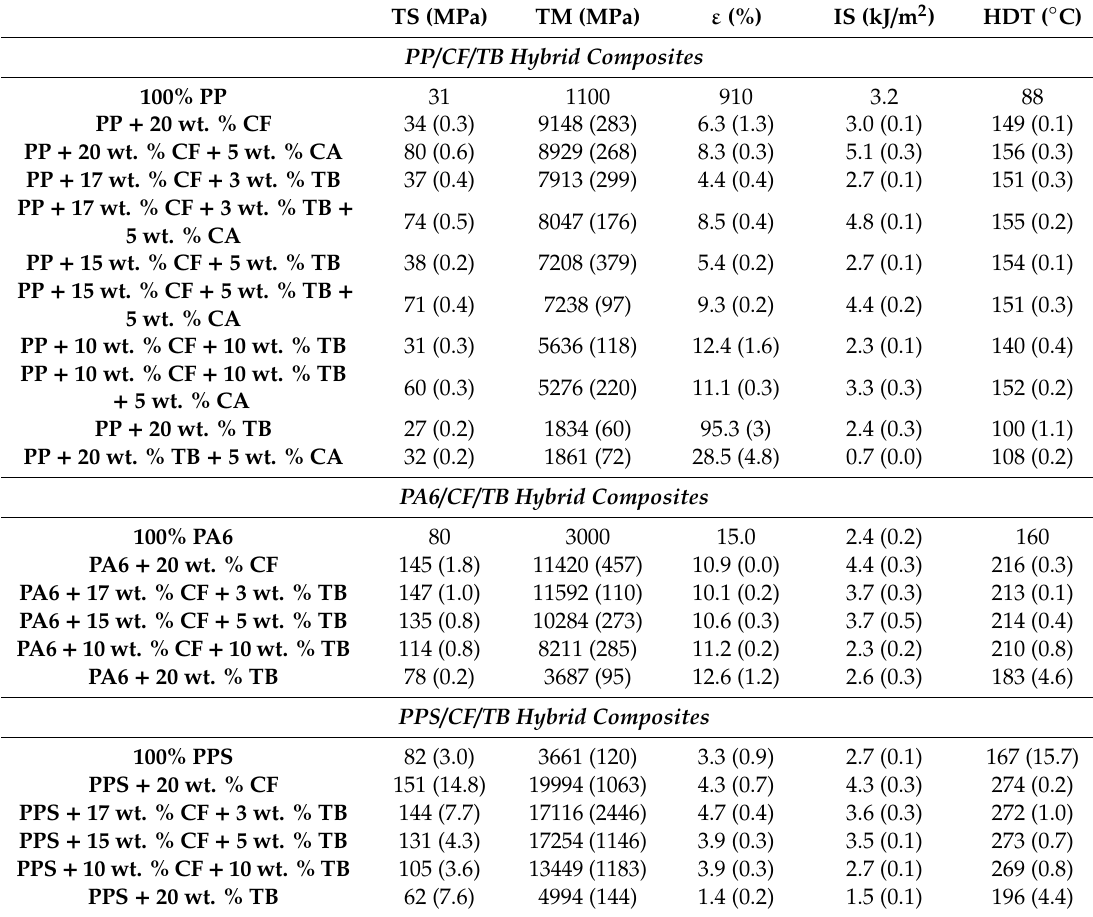
Table 6. Properties (and SD) of PP, PA6, and PPS / CF / TB hybrid composites.